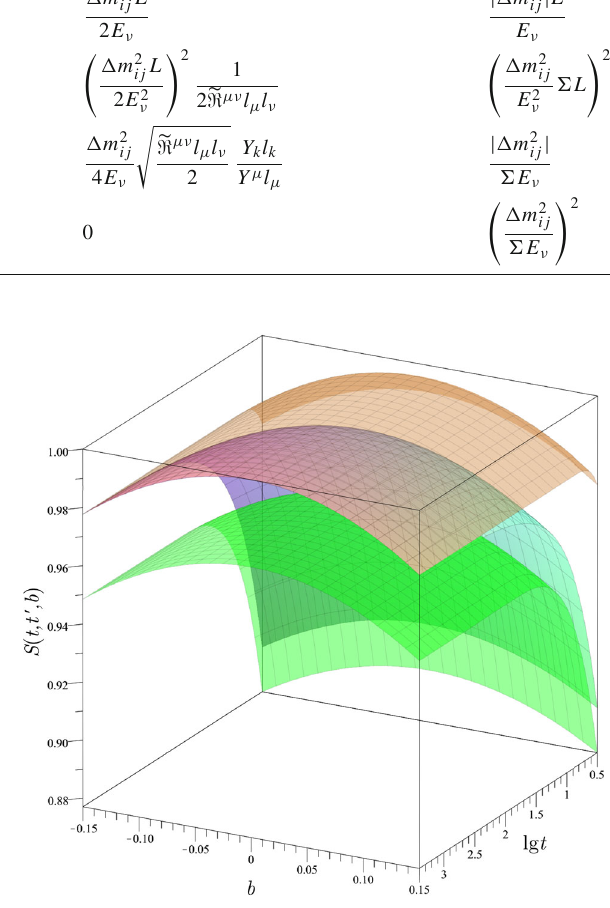
Fig. 5 Instrumental factor (65) at t (cid:15) = 0 . 97 t , t (cid:15) = t and t (cid:15) = 1 . 30 t vs. lg t and b shown by the lower, middle and upper surfaces, respectively. The middle and upper surfaces merge at very large